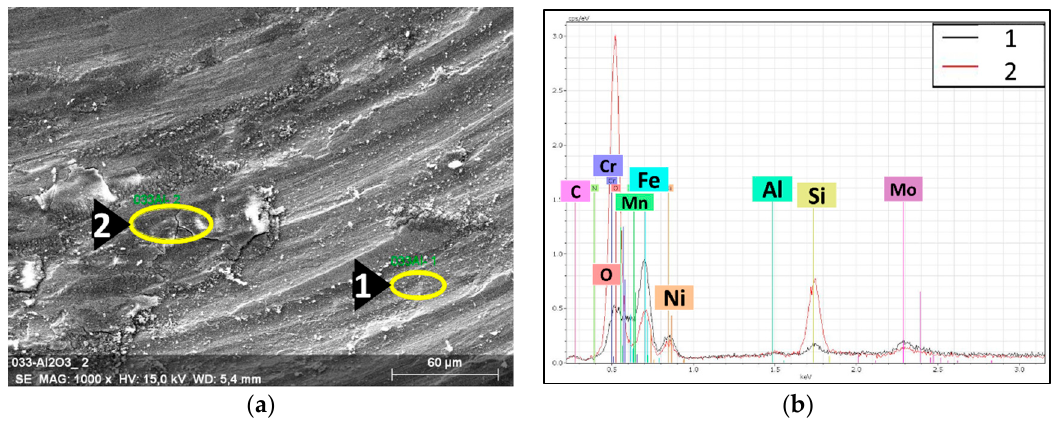
Figure 12. EDS spectra with the associated SEM images of the tribological wear track of the 316L/0.33 wt% Al 2 O 3 . ( a ) SEM image of the wear track; ( b ) EDS spectra of the selected spots.